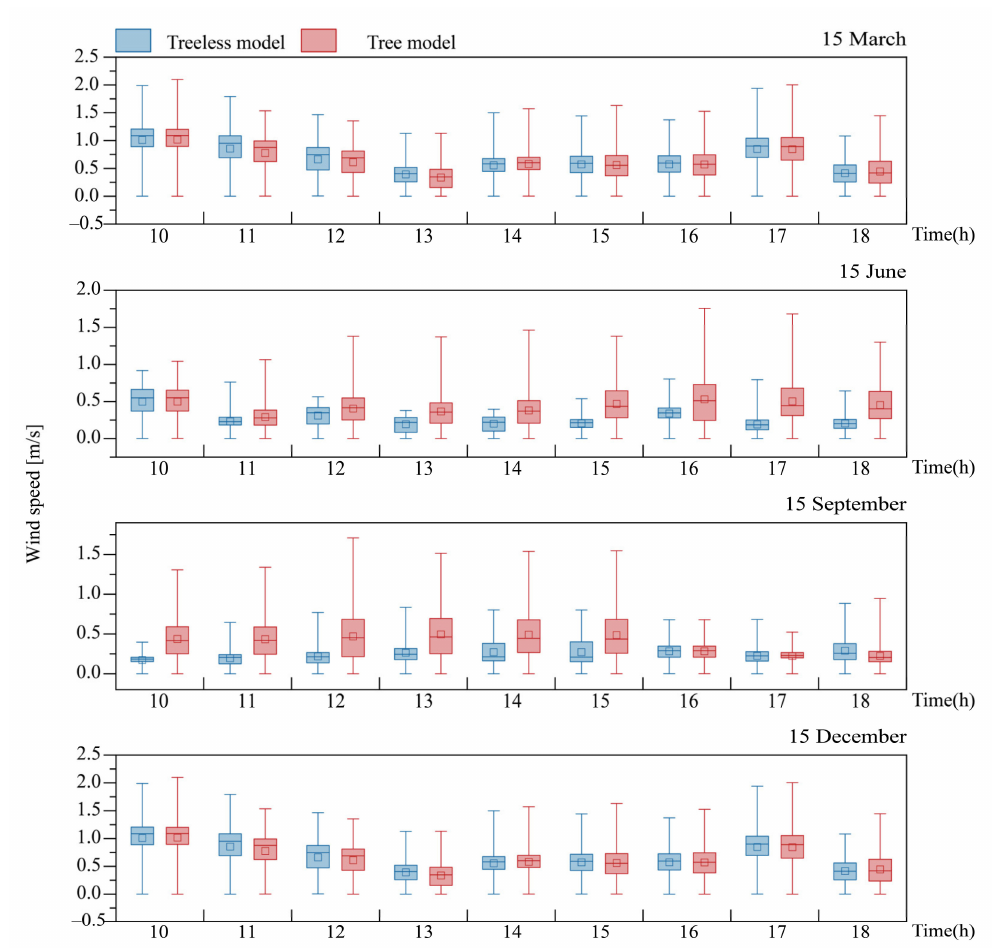
Figure 9. Comparison of the range of wind speed between two models at a height of 1.2 m on four